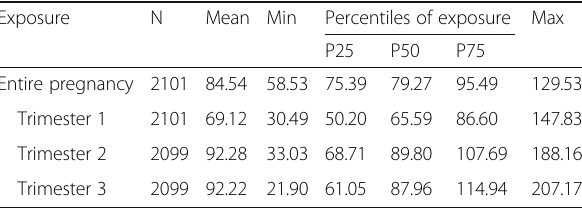
Table 2 Average exposure level of PM 2.5 in each time window based on LUR model estimates of the study population in Wuhan, China